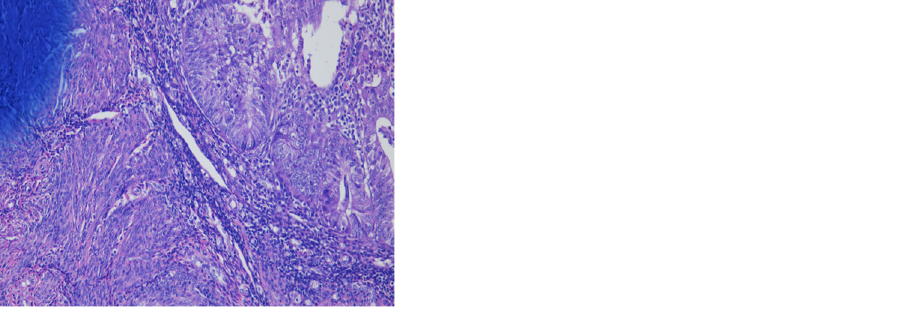
Figure 2. Thin rim of endometrial stroma between tumor–myometrium junction means no myome- trial invasion (200× magnification).